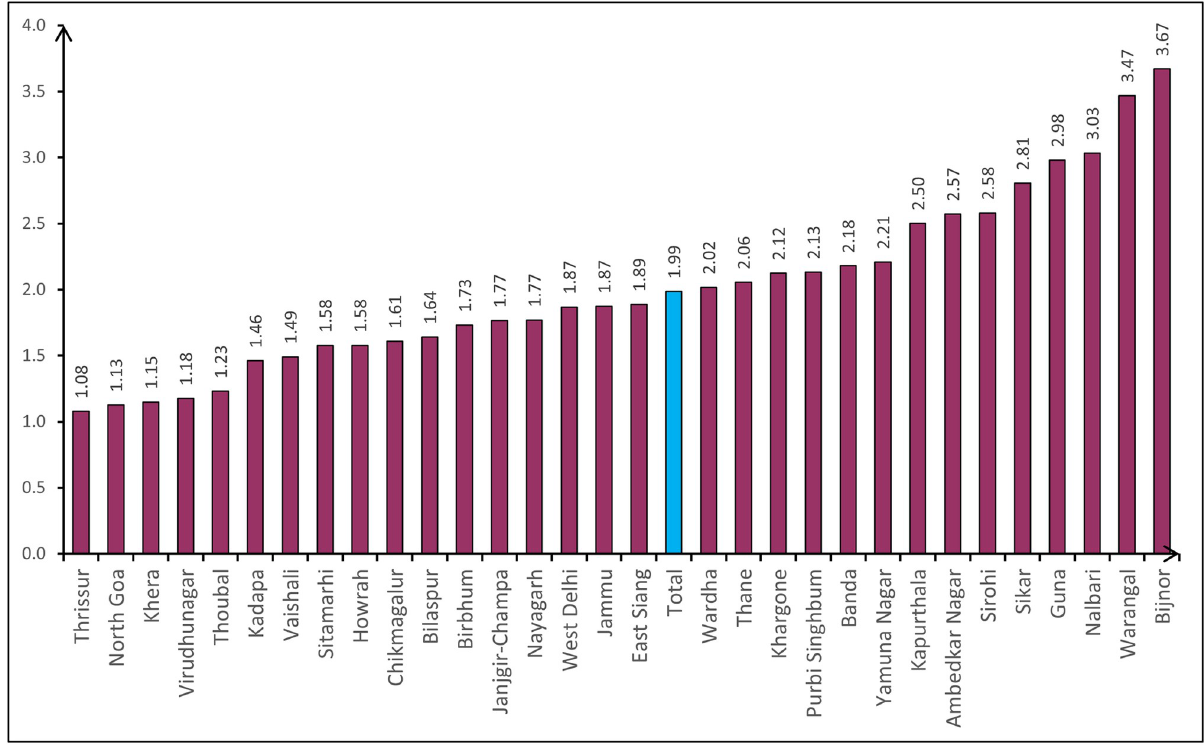
Fig 1. District-wise prevalence of blindness (PVA Better eye < 3/60) in population aged � 50 years in 31 districts of India.